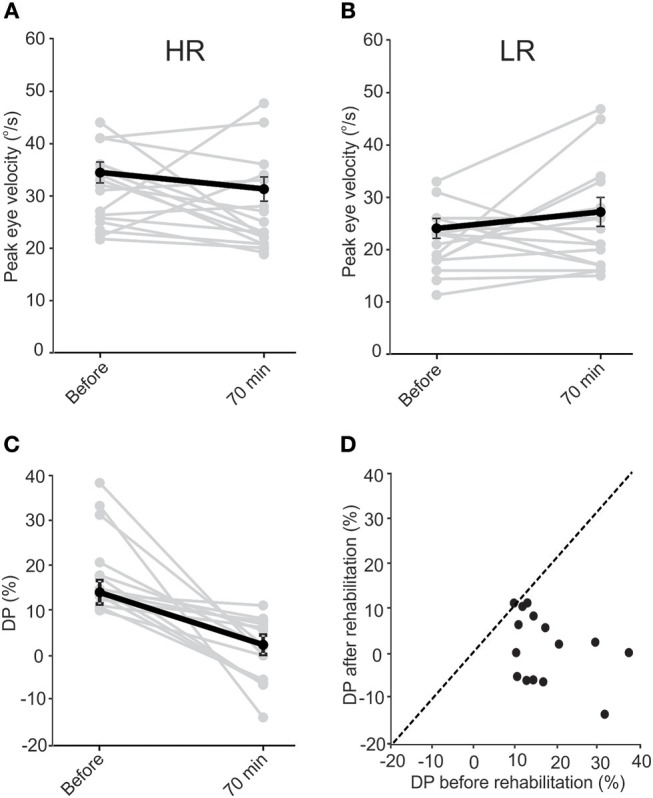
Data pooled from all sessions of subjects in the long-term study. “Before” data is from the initial values collected before rehabilitation in each session. “After” data is collected 70 min after rehabilitation in each session. VOR responses for LA and HA rotations were different “before” rehabilitation (paired t-test, p = 0.003). Similar to the short-term study, in the majority of instances rehabilitation resulted in a decrease in VOR responses during HA rotations (A) and an increase in responses during LA rotations (B), resulting in the responses to rotations in the two directions to be similar after rehabilitation (paired t-test, p = 0.85). While the change in response averages were not significant for HA (paired t-test, p = 0.33) and LA (paired t-test, p = 0.11) responses, the average DP (C) still decreased significantly (paired t-test, p = 0.002). Except in one session for one of the subjects, DPs either decreased or did not change after rehabilitation. This is shown by the points lying below the dashed identity line in (D).